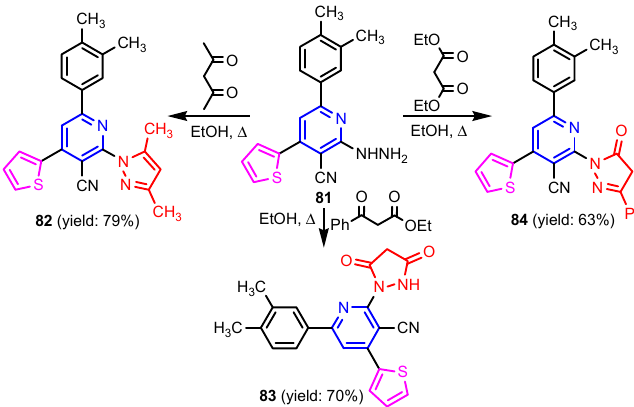
Scheme 15. Synthesis of thiophene-pyridine compound 80 [39].